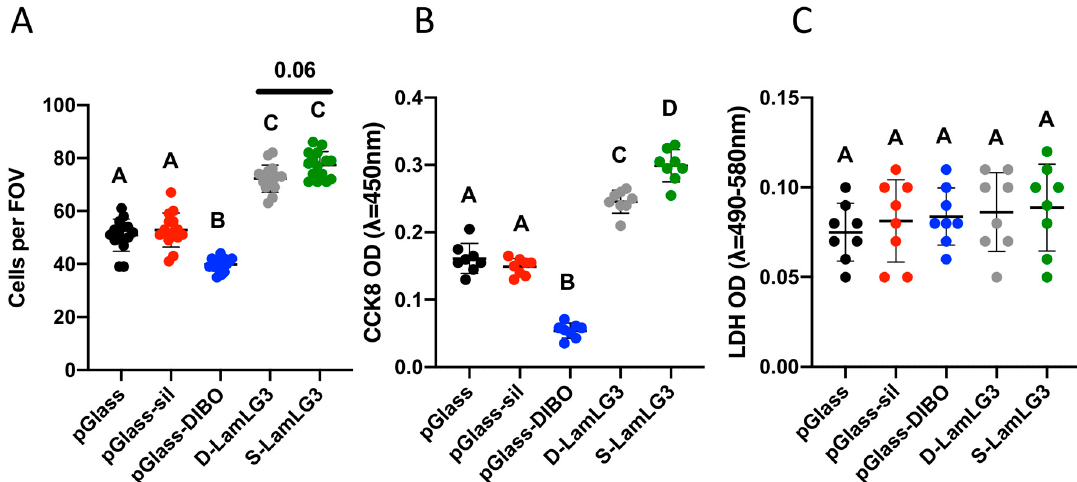
Figure 4. Oral keratinocyte proliferation [number of cells ( A ) and metabolic activity ( B )] and cytotoxicity [LDH release ( C )] of LamLG3-coated and non-coated, control surfaces after 1 day of culture. Di ff